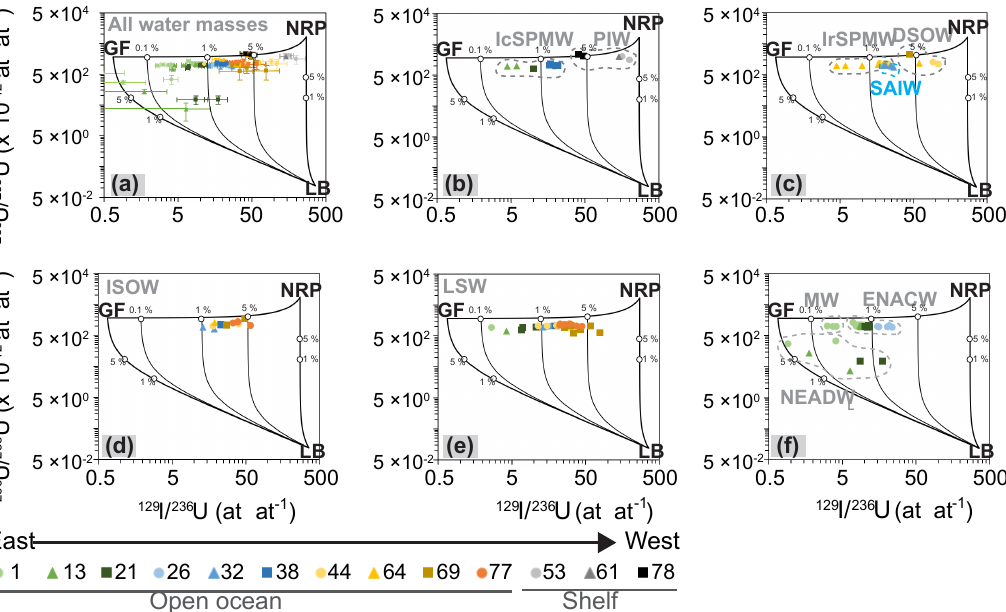
Figure 4. 129 I / 236 U and 236 U / 238 U atom ratios obtained during the GEOVIDE cruise in spring 2014 plotted on top of a binary mixing model (details in Sect. 3.3) to estimate the contribution from the three sources to the subpolar North Atlantic (global fallout, GF; European nuclear fuel reprocessing plants, NRP; and the natural or lithogenic background, LB). Data are plotted for (a) each station, and (b–f) for the main water masses described in Sect. 3.1. Diagram (a) also shows the data uncertainties. An explanation on how to interpret the results is provided in Sect. 3.3. Further detail about the binary mixing model can be found in the original study (Casacuberta et al., 2016). Water mass acronyms are defined in the